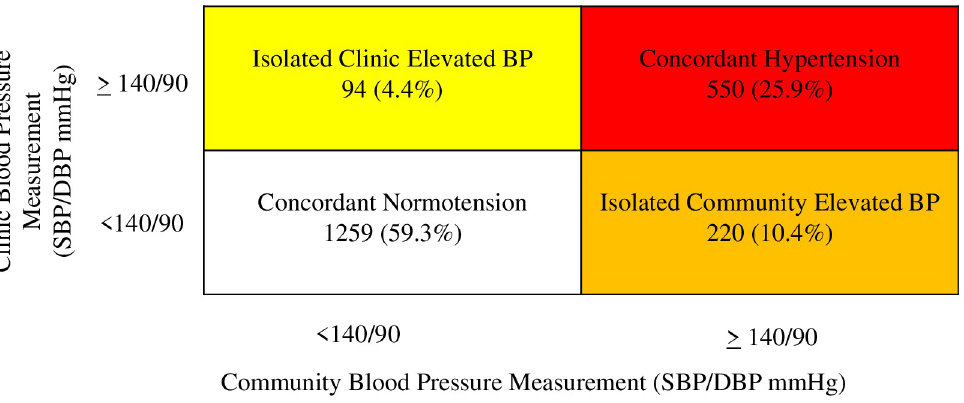
Fig 3. Classification of blood pressure status categorization according to clinic and community measurements (N = 2123). Concordant Normotension: BP < 140/90 at home and at the clinic measurement. Concordant Hypertension: BP � 140/90 at home measurement and at the clinic measurement OR the participant reports taking antihypertensive medication (regardless of the BP in either setting). Isolated Clinic Elevated BP: BP < 140/90 at community measurement and BP � 140/90 at the clinic measurement. Isolated Community Elevated BP: BP � 140/90 at community measurement and BP < 140/90 at the clinic measurement.